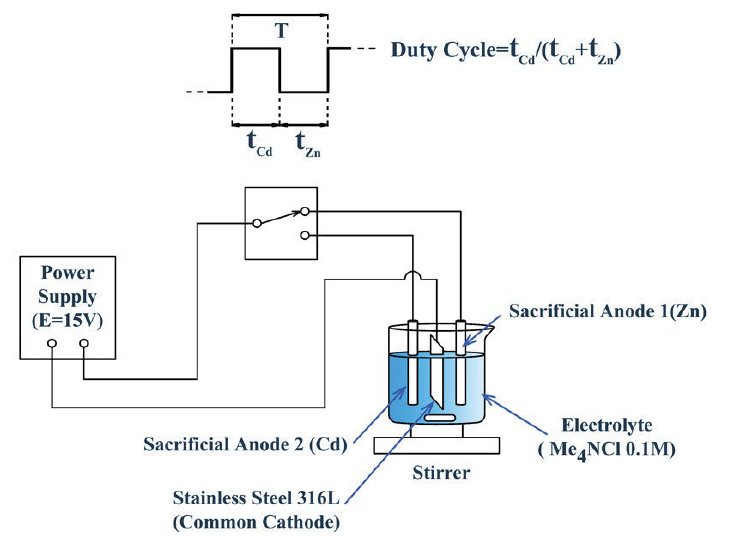
Fig. 1.Schematic diagram of the experimental